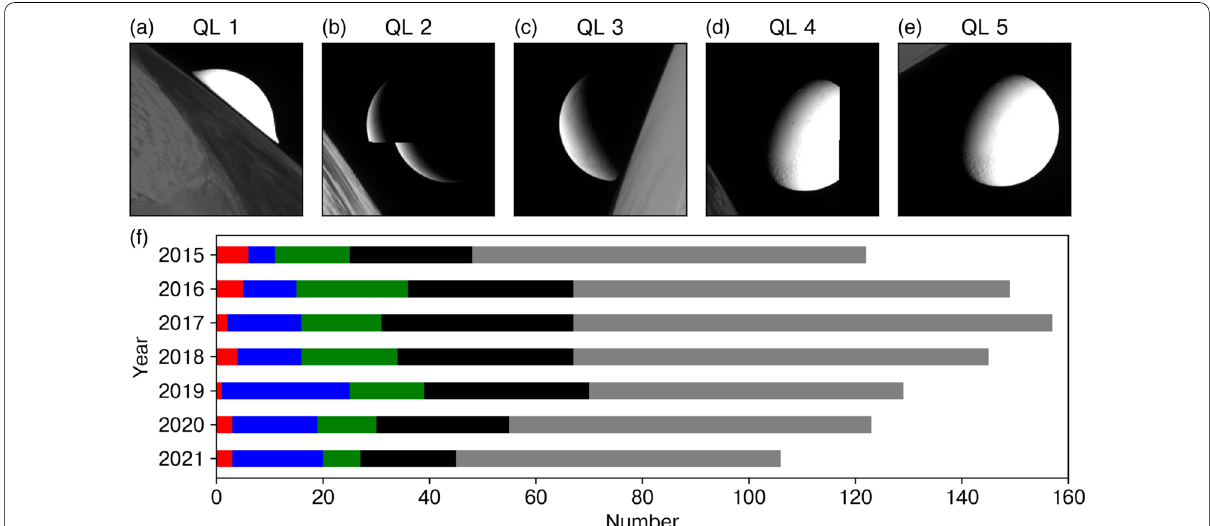
Fig. 2 a – e Example images of quality level (QL) 1–5. QL of 1, 2, 3, 4, and 5 correspond to the Moon hidden more than half, cut by swath boundaries, hidden partly by the Earth, partly out of the scanned area, and fully captured, respectively. The images were retrieved from the band-13 data taken at 2015/04/01 00:40, 2016/10/26 12:00, 2016/11/23 09:30, 2016/12/09 23:20, and 2017/10/30 23:10. f The histogram of the number of QLs for each year from 2015 to 2021. The gray, black, green, blue, and red bars correspond to QL of 1, 2, 3, 4, and 5,